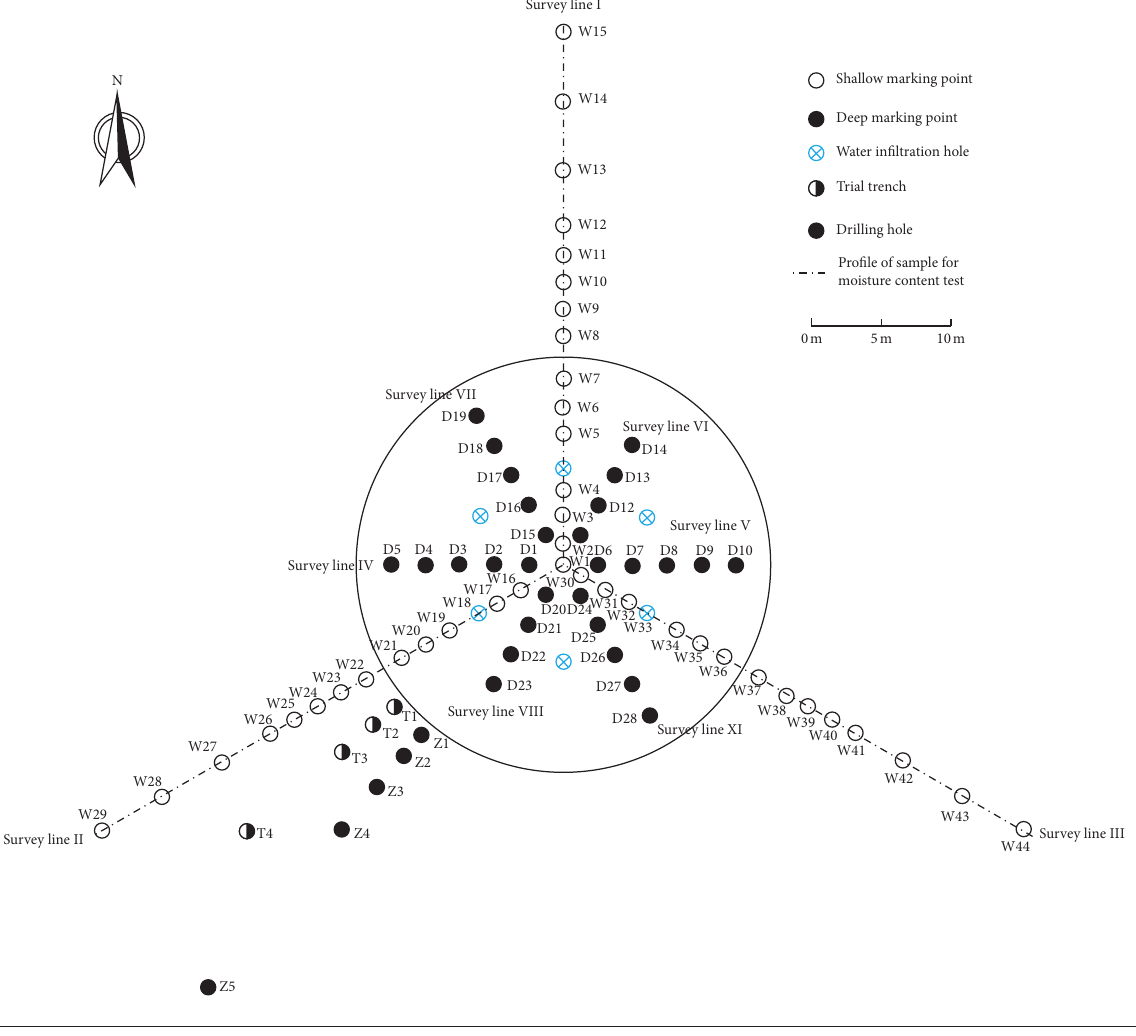
Figure 3: The layout of water immersion